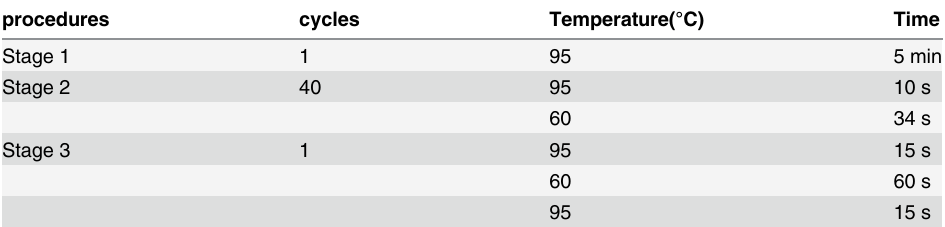
Table 2. qRT-PCR program details.